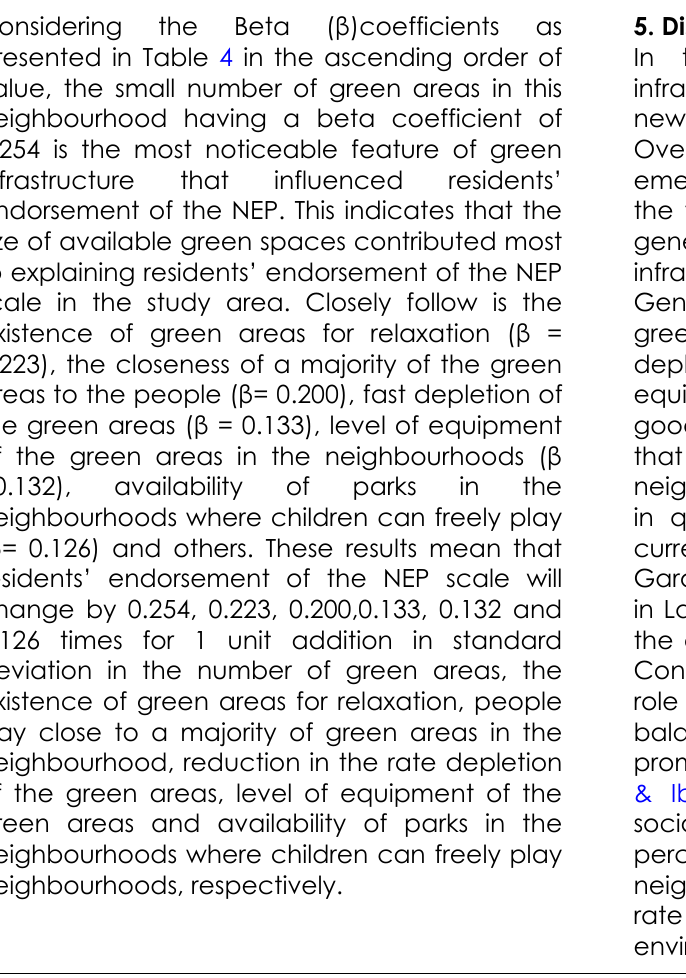
Features of Green